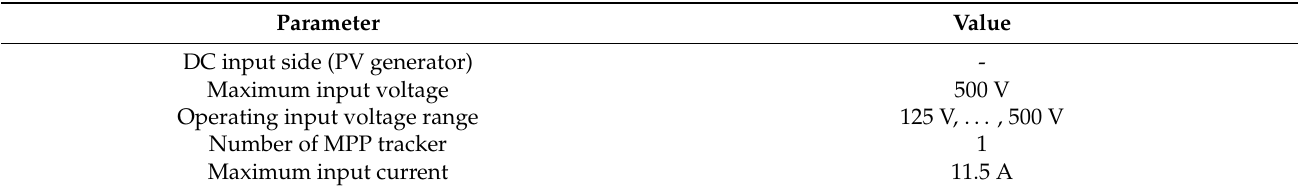
Table A2. Specifications of the Steca Coolcept StecaGrid 3010 inverter (single phase) [72].